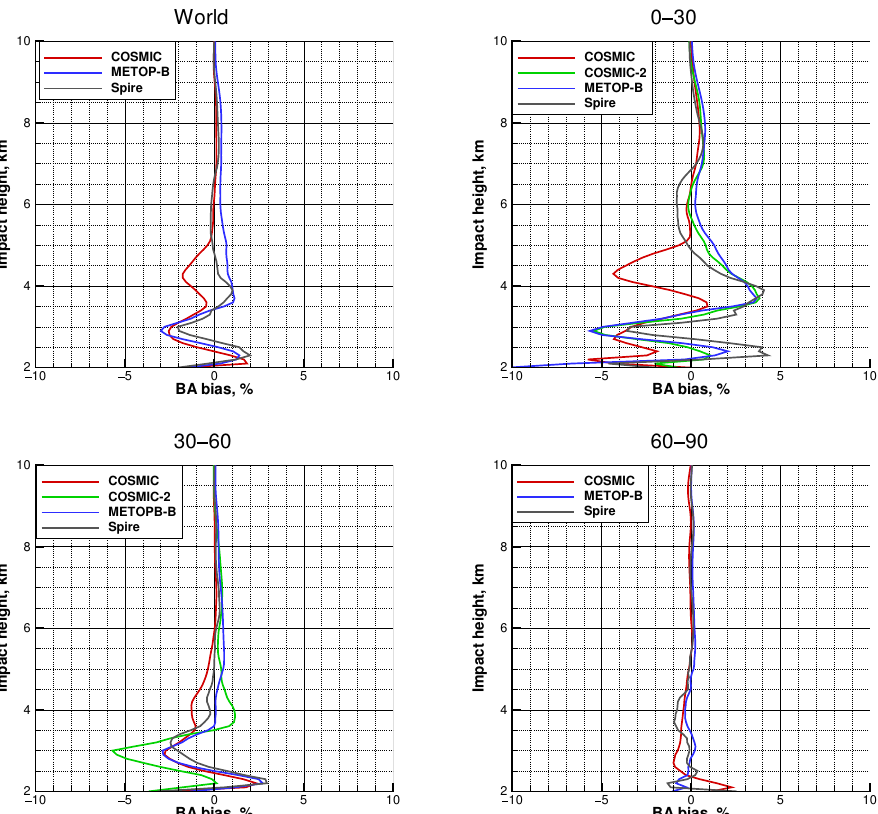
Figure 14. Statistical comparison of bending angles retrieved from RO observations with GFS analyses for different missions and for a normalized SNR of 70. Systematic difference, dynamic normalization. Upper left: world, upper right: tropics, lower left: middle latitudes, lower right: polar latitudes. All the latitude bins cover both North and South